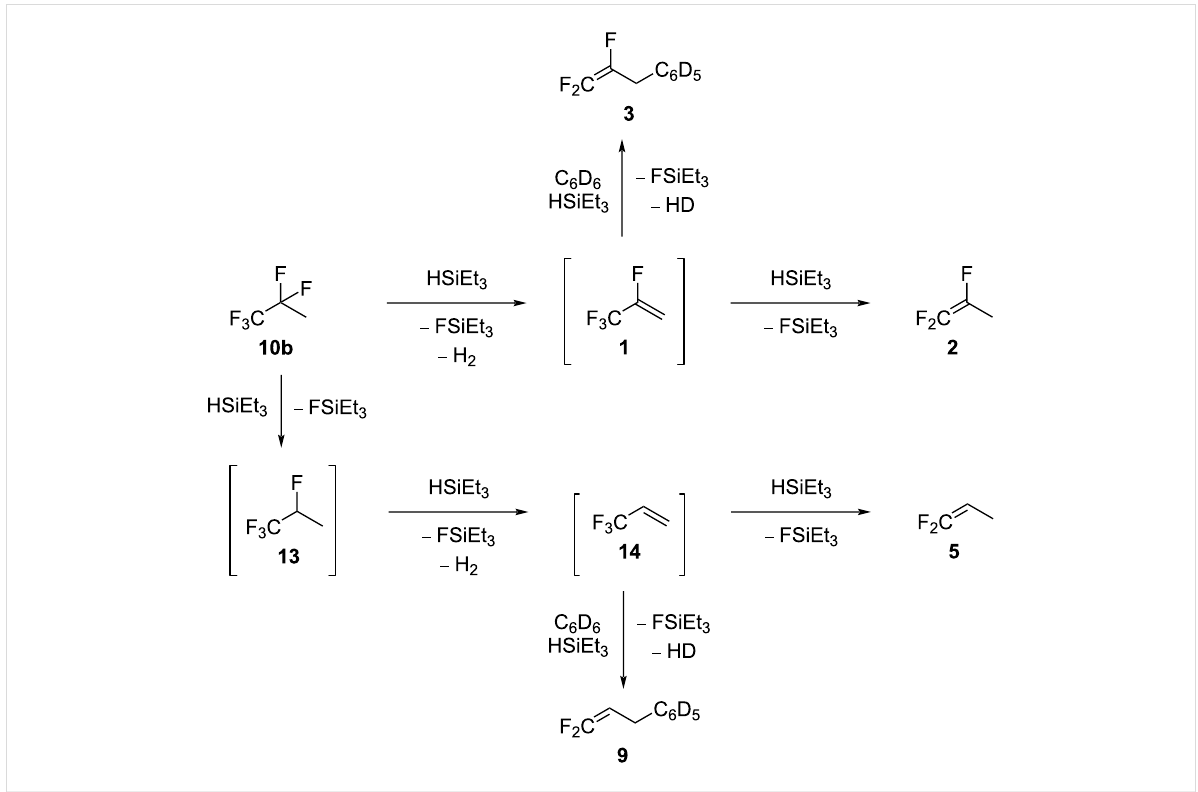
Scheme 14: Proposed reaction pathway starting from 10b in the presence of ACF and